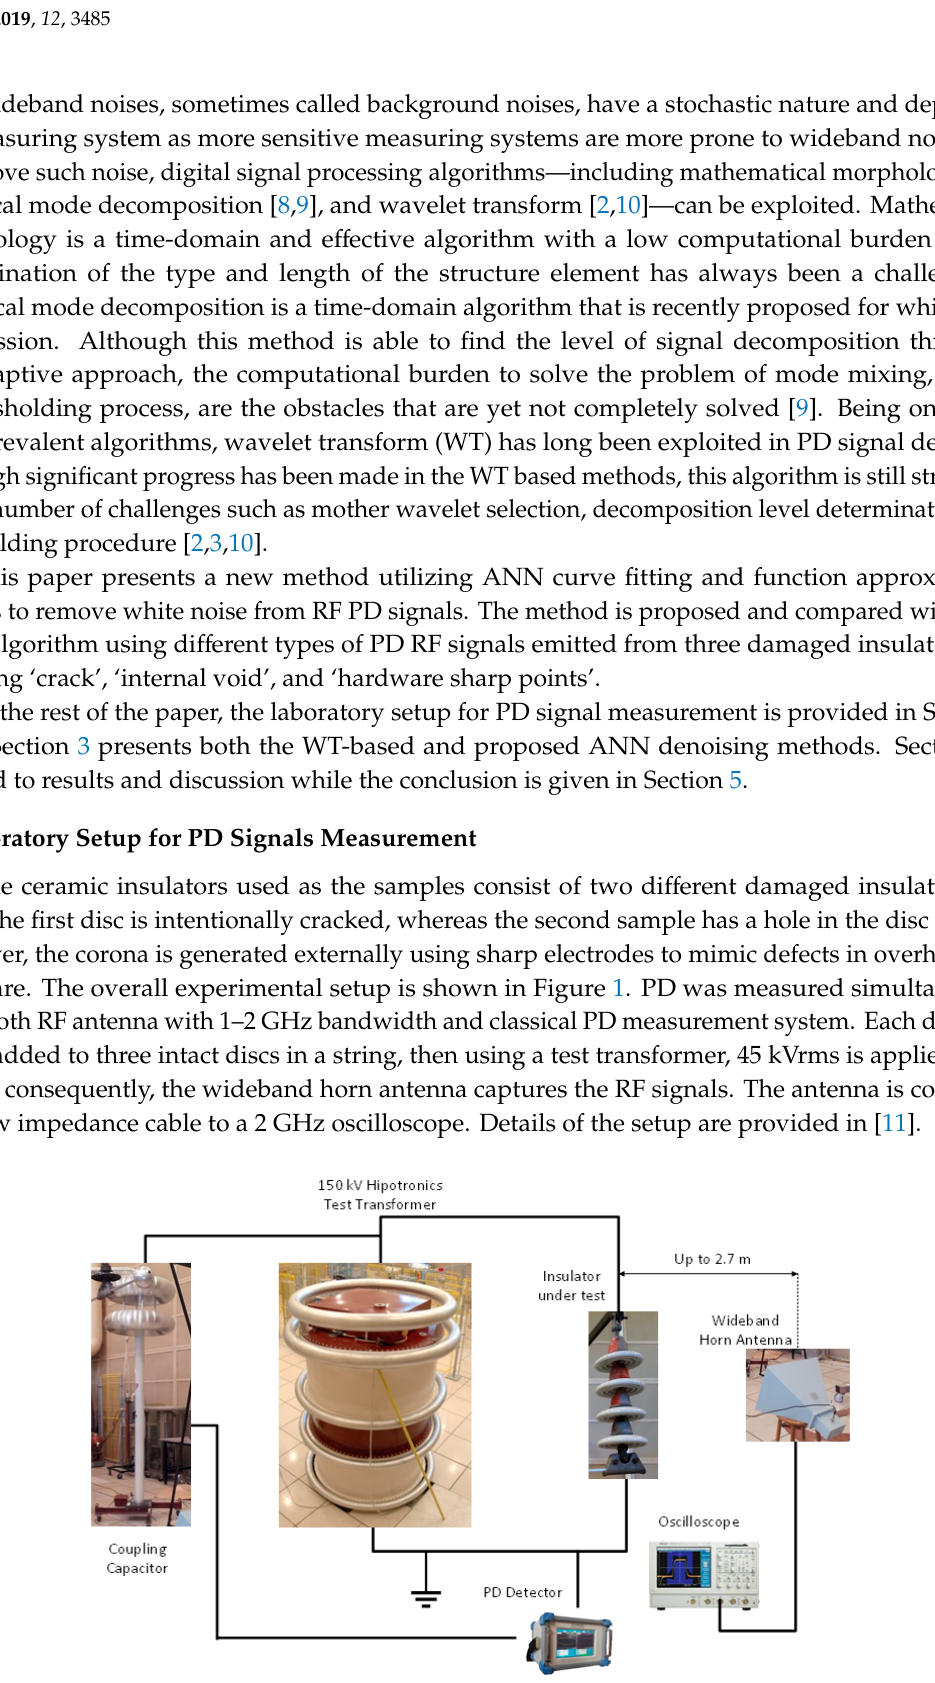
Figure 1. Laboratory setup for simultaneous electrical and RF signals measurement from the source of partial discharge, defected insulator disc.